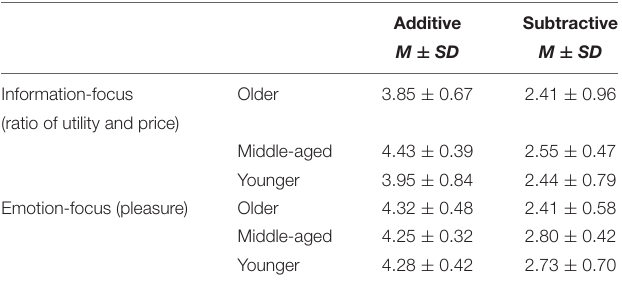
TABLE 4 | The ratio of utility and price/pleasure evaluated by participants in additive and subtractive framing.